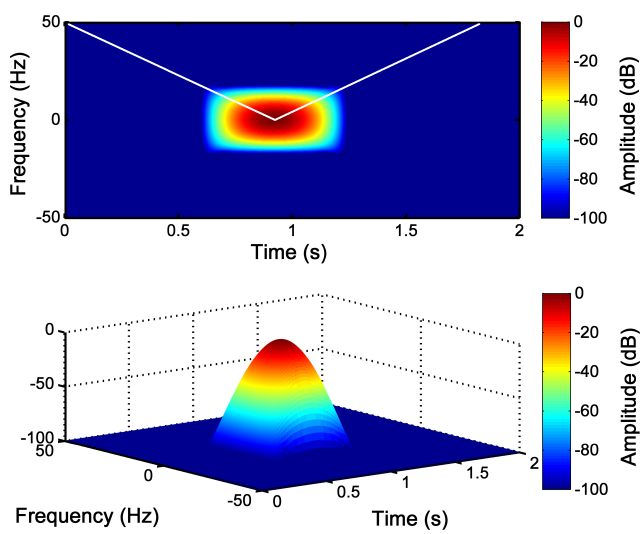
Figure 7. Slepian window ( B W = 20.85 Hz, T W = 383.7 ms) optimized for representing the LSH, as a 2D view ( top ) and as a 3D view ( bottom ) in the time-frequency plane. The white line marks the trajectory of the LSH in this